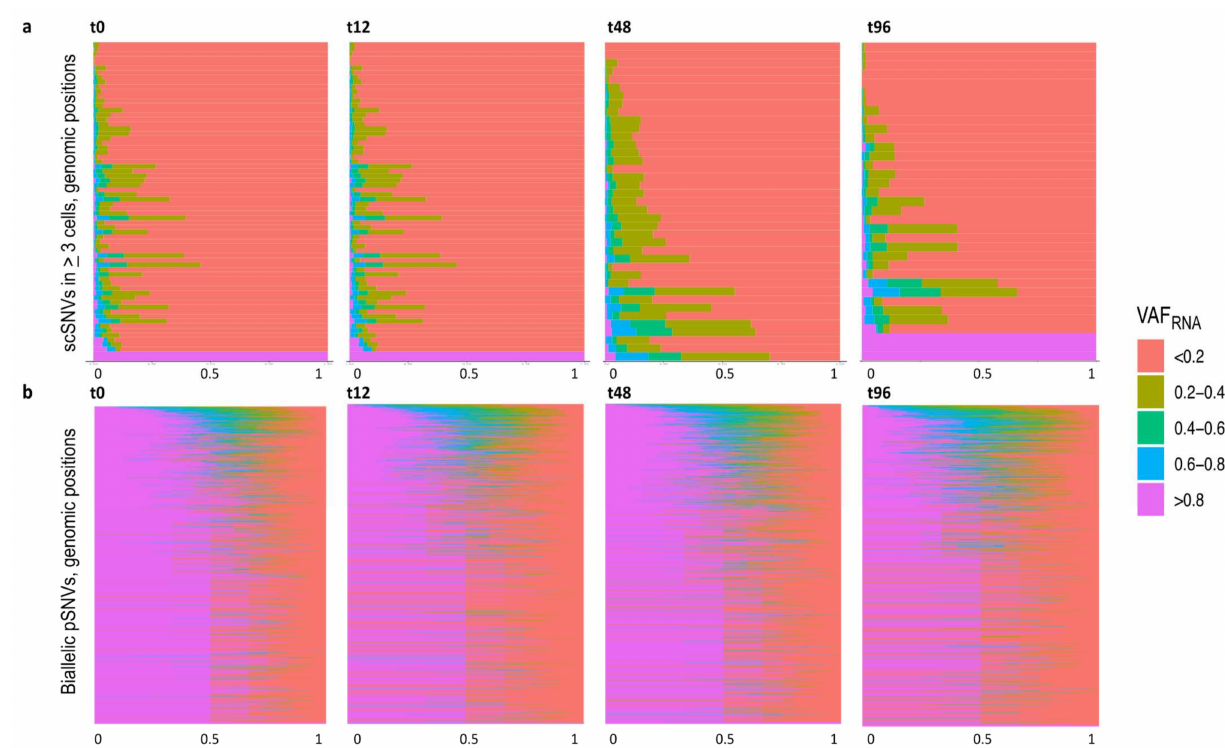
Figure 4. ( a ). ScVAF RNA estimated at positions covered by a minimum of 3 sequencing reads (minR = 3) for sceSNVs called in 3 and more cells per dataset (y-axis). The majority of the positions have a VAF RNA up to 0.2. Note that the plot is inclusive for all the cells with minR = 3 in the corresponding position, including those covered with reference reads only. The percentage of cells with a corresponding VAF RNA is displayed on the x-axis. ( b ). ScVAF RNA estimated at those positions covered by a minimum of 3 sequencing reads for biallelic pSNVs (y-axis). For most of the pSNVs, the VAF RNA distribution is centered around 0.5, which is expected for germline heterozygous SNVs not subjected to monoallelic